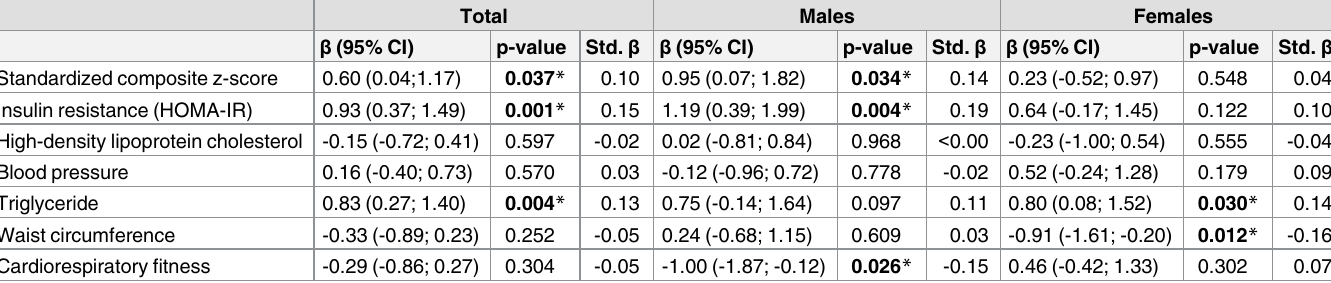
Table 2. Associations of serum BDNF (ng/ml) with composite z-score and single cardiovascularrisk